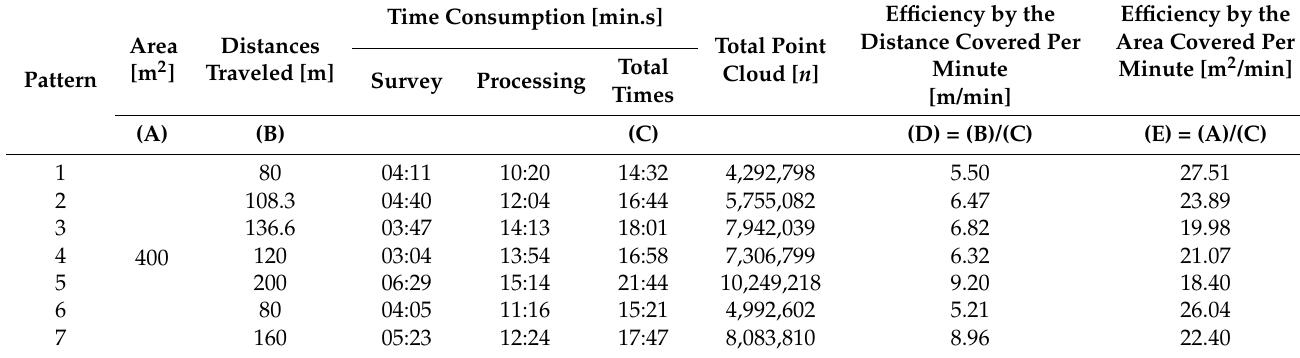
Table 8. Comparison of efficiency between field survey and BPLS survey. Survey Personnel Method Field